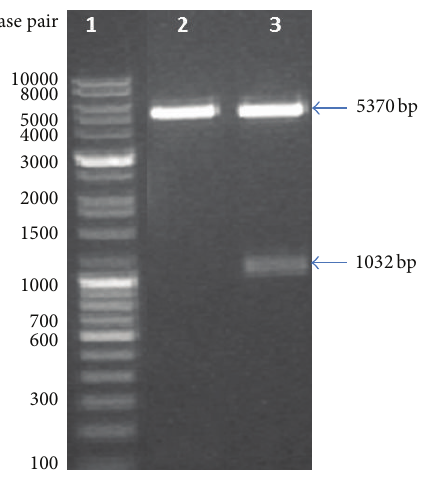
Figure 1: Characterization of pYBL01-ST3Gal-I clone: lane 1: 1Kb DNA ladder, Merck; lane 2: Backbone vector digested with NcoI/HindIII enzymes and the expected band size is 52 bp and 5370 bp; lane 3: pYBL01-ST3Gal-I clone, digested with NcoI/HindIII enzymes and the expected band sizes are 1032 bp and 5370 bp.